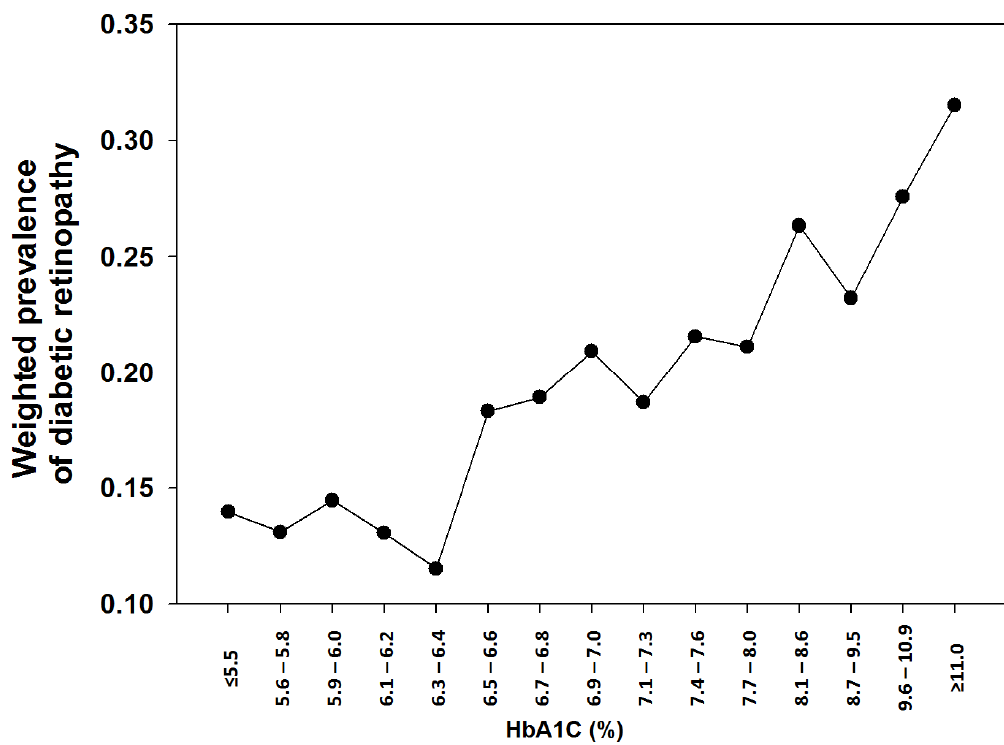
Figure 1. Weighted prevalence of diabetic retinopathy in subjects with established diabetes.